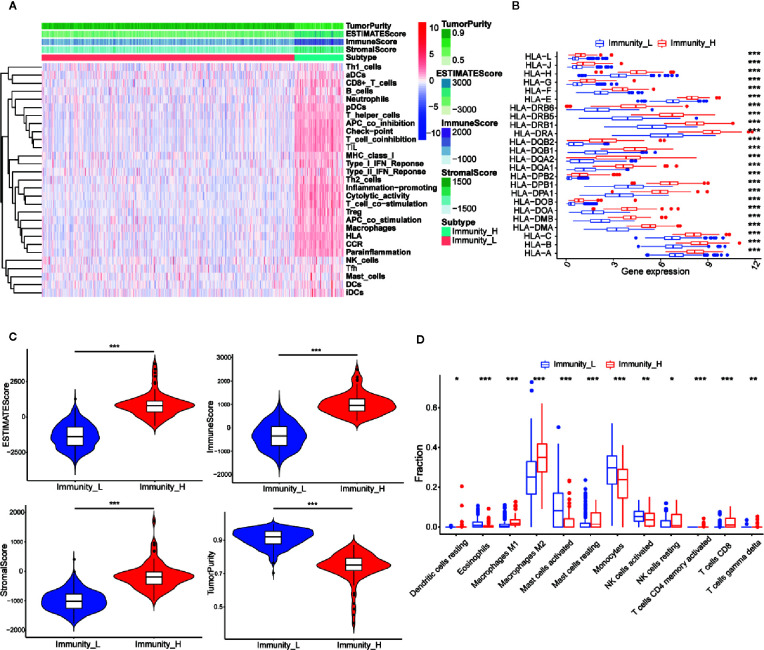
Establishment and verification of LGG grouping. (A) The heatmap showed the unsupervised clustering of 29 immune-associated gene sets in the high immune group (Immunity_H) and the low immune group (Immunity_L). Parameters including tumor purity, ESTIMATE scores, immune scores, and stromal scores. (B) The histogram showed the differences in expression levels of HLA and family gene between the high and low immunity groups. (C) The violin diagram showed the difference in tumor purity, ESTIMATE scores, immune scores and stromal scores. (D) The CIBERSORT algorithm obtained that the infiltration level of most immune-related cells in the high immune group is lower than that in the low immune group, such as Dendritic cells resting, Macrophages M1, Macrophages M2, Mast cells resting, NK cells resting, T cells CD4 memory activated, T cells CD8, and T cells gamma delta. *p < 0.05; **p < 0.01; ***p < 0.001.